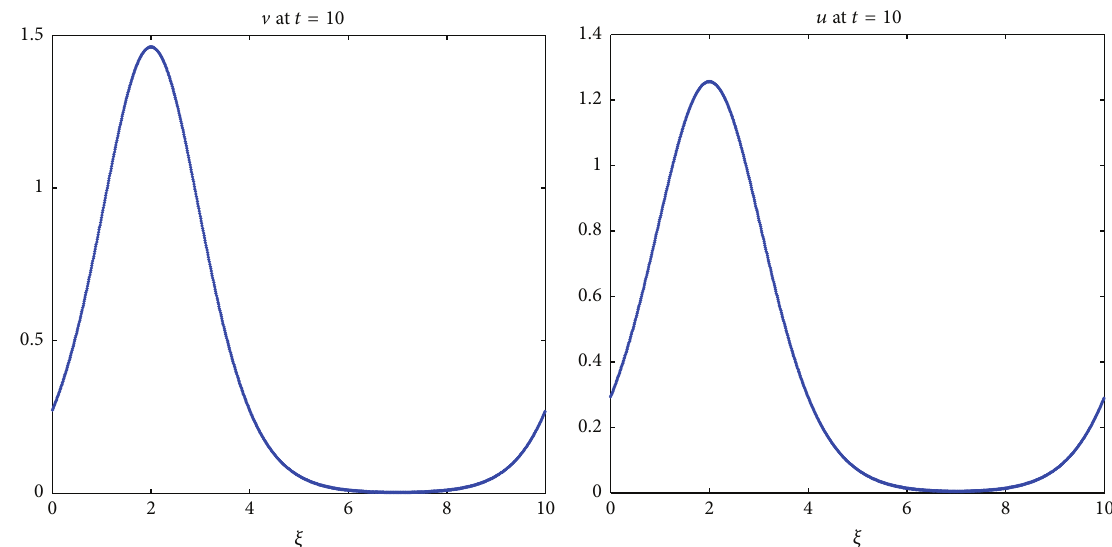
Figure 6: Evolution of a periodic travelling wave solution of system (75) for 𝛼 = 𝛽 = 0.3 , 𝜎 = 0 , wave speed 𝑐 = 1.2 , and period 𝐿 = 10 , using the numerical scheme (83).